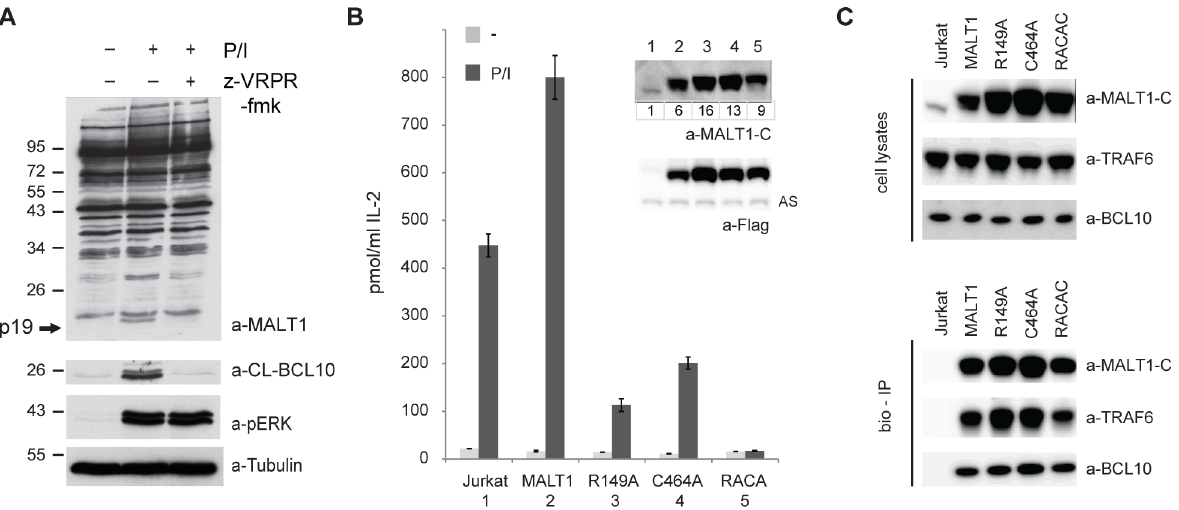
Figure 6. MALT1 auto-proteolysis is required for IL-2 production by Jurkat T cells. A) Jurkat T cells were left untreated or stimulated with P/I for 30 min, with or without pre-treatment with 50 m M z-VRPR-fmk for 30 min. Lysates were analysed for the presence of the cleavage fragments for BCL10 and MALT1 p19, for p-ERK (activation control) and tubulin (loading control). B) IL-2 production (ELISA) of Jurkat T cells stably expressing MALT1, MALT1-R149A, MALT1-C464A or MALT1-RACA, either untreated (-) or stimulated for 18 hrs with PMA/ionomycin (P/I). Data shown as mean + /- S.D. (n=3). Inset: Immunoblot with a-MALT1-C and a-Flag showing expression of ectopic MALT1 and mutants relative to endogenous MALT1 (lane 1). Numbers indicate fold overexpression relative to endogenous MALT1. AS: a-specific band obtained with a-Flag that serves as loading control. C) Immunoblot of cell lysates (top) and bio-IPs (bottom) from Jurkat T cells and Jurkat T cells with stable expression of Avi-tagged MALT1 or MALT1 mutants R149A, C464A and RACA with indicated antibodies.